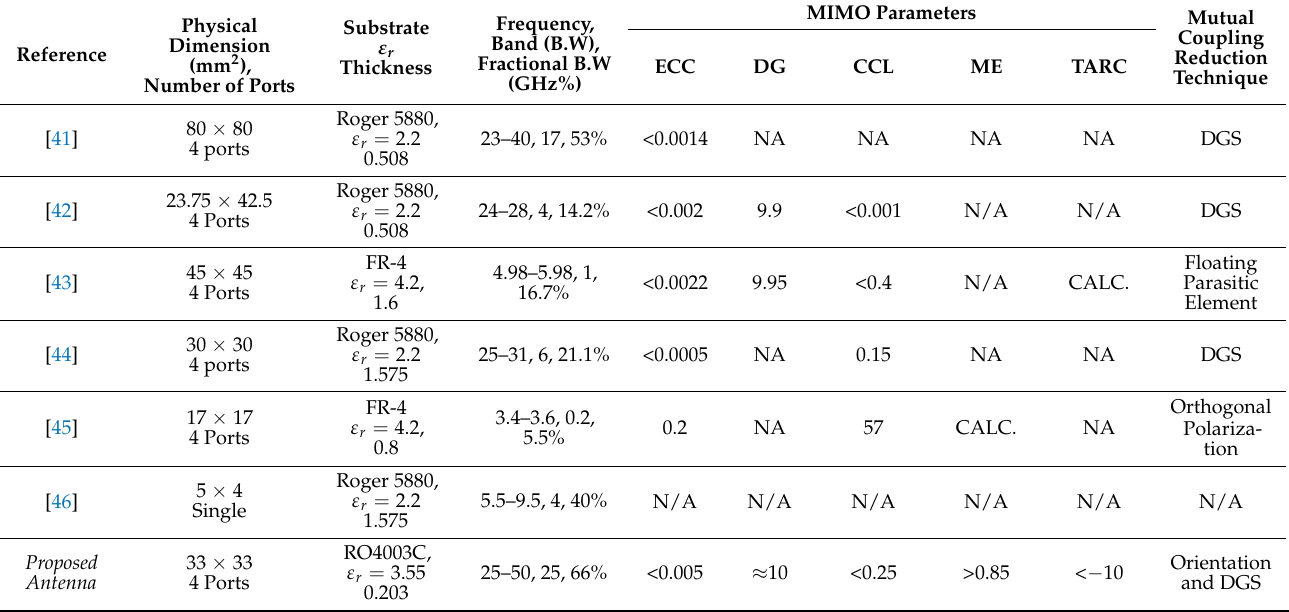
Table 1. Comparisons between the proposed MIMO antenna system and the published literature operating in 25–50 GHz band.